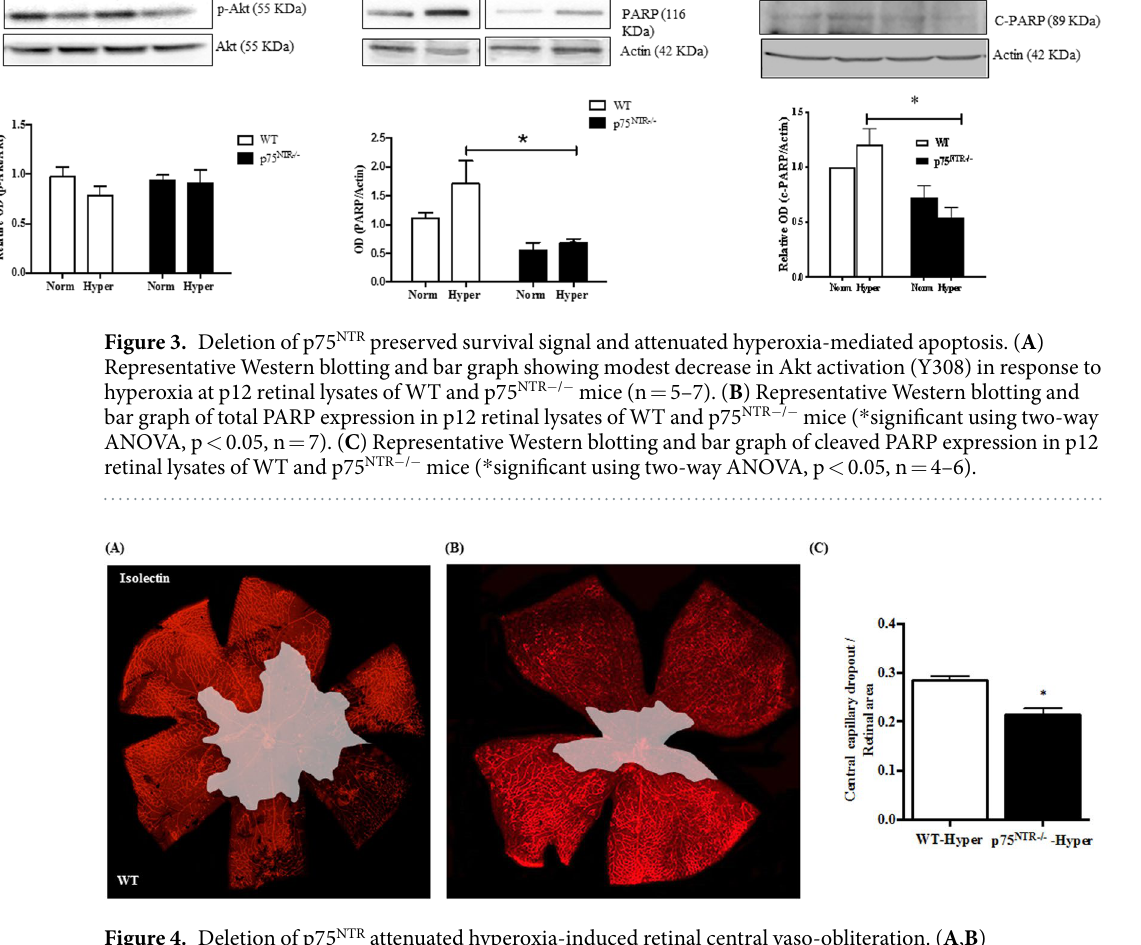
Figure 4. Deletion of p75 NTR attenuated hyperoxia-induced retinal central vaso-obliteration. ( A , B ) Representative images of Isolectin GS-stained retinal flat mounts of WT and p75 NTR − / − pups showing capillary drop-out (CDO) illustrated by encircled area at the center at p12 (magnification is 5X). ( C ) Bar graph and statistical analysis using unpaired student T-test for CDO showing significant reduction of CDO in p75 NTR − / − compared to WT pups in response to hyperoxia ( * significant compared to WT-hyperoxic group, p < 0.05, n = 8–12). (Hyper) hyperoxia-exposed group, (Norm) normoxic controls, (CDO): central capillary